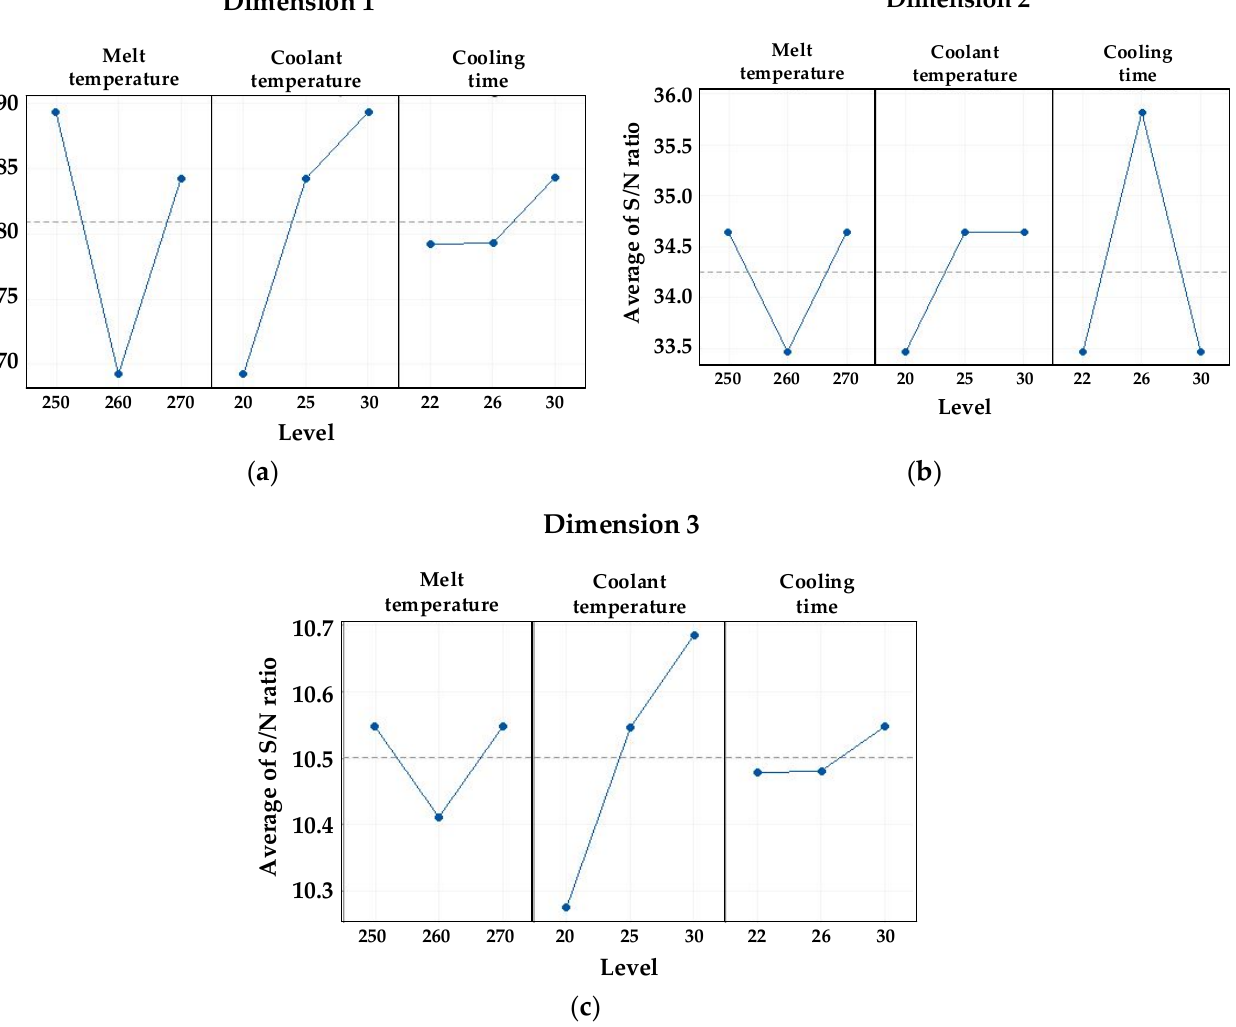
Figure 10. Average of S/N ratio for each level of factors in the pivot sub-assembly-obtained graph. ( a ) Dimension 1 ( b ) Dimension 2 ( c ) Dimension